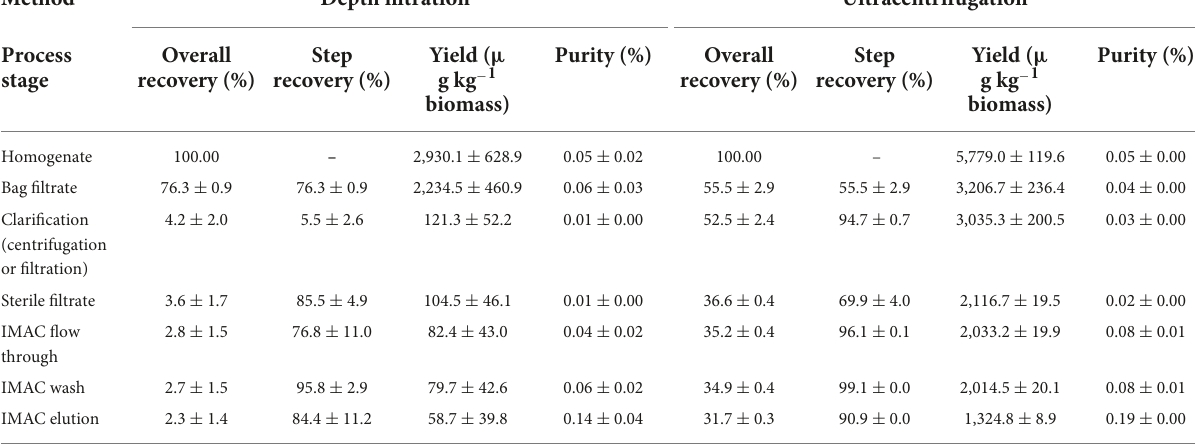
TABLE 4 Comparison of purification process performance for nTf338-FGF21-PLUS extracted from non-senescent, transiently transformed N. benthamian a leaves, using filtration or centrifugation as the major clarification step. Method